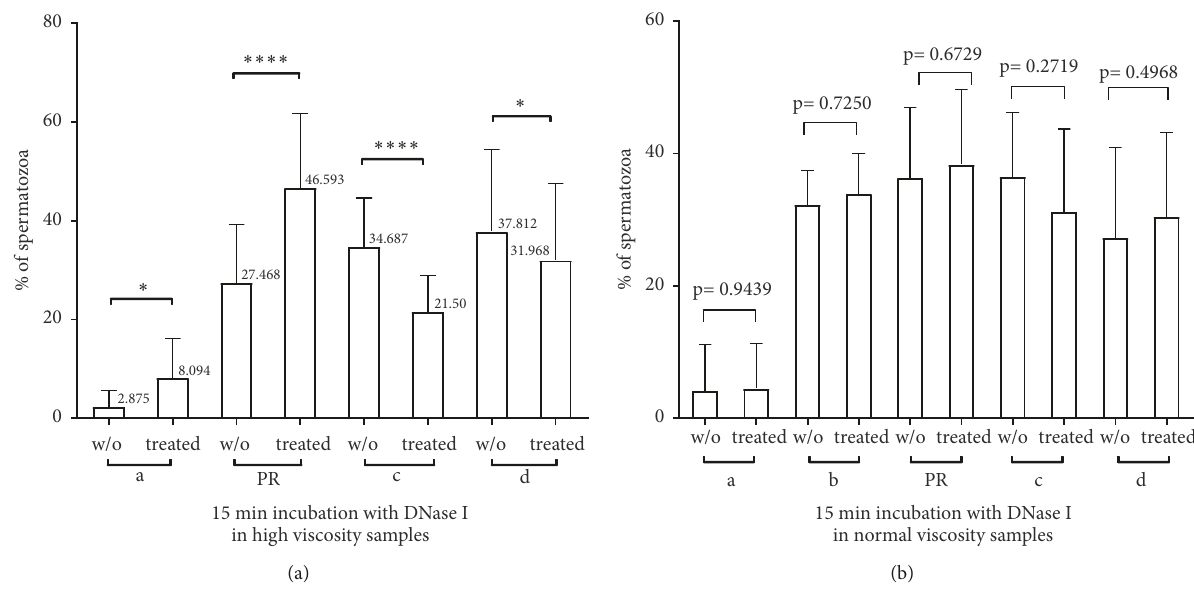
Figure 2: Effects of DNase I in sperm motility after 15 min incubation with DNase I. DNase I improves PR movement in a statistical significant manner in hyperviscous semen (a) but has no effect in sperm with normal viscosity (b). w/o: sperm without treatment, treated: sperm treated with DNase I, a: rapid progressive spermatozoa, b: slow progressive spermatozoa, c: non-progressive, d: immotile, and PR: motility of (a+b).